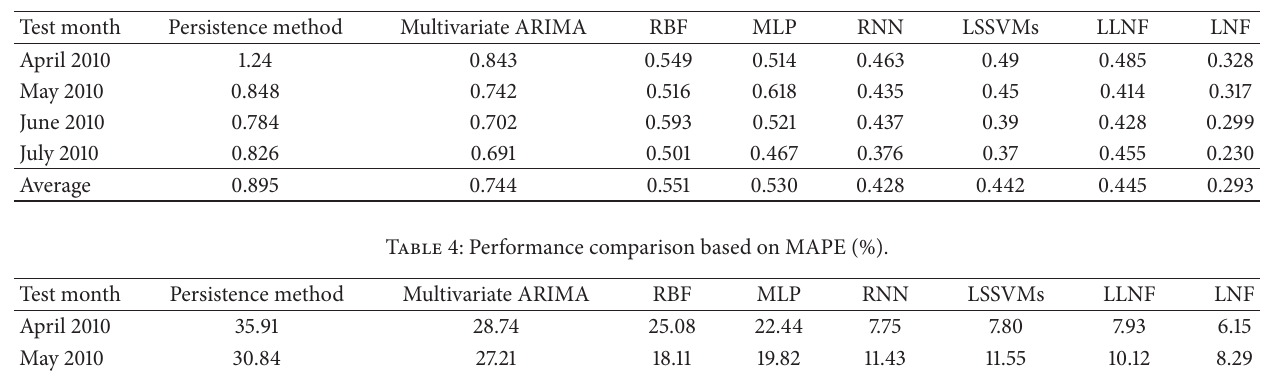
Table 3: Performance comparison based on RMSE.